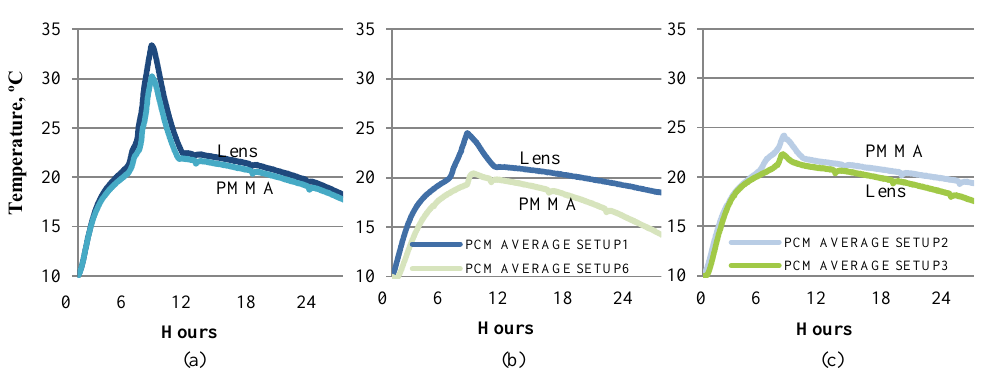
Fig. 8. Room temperatures in all setups.